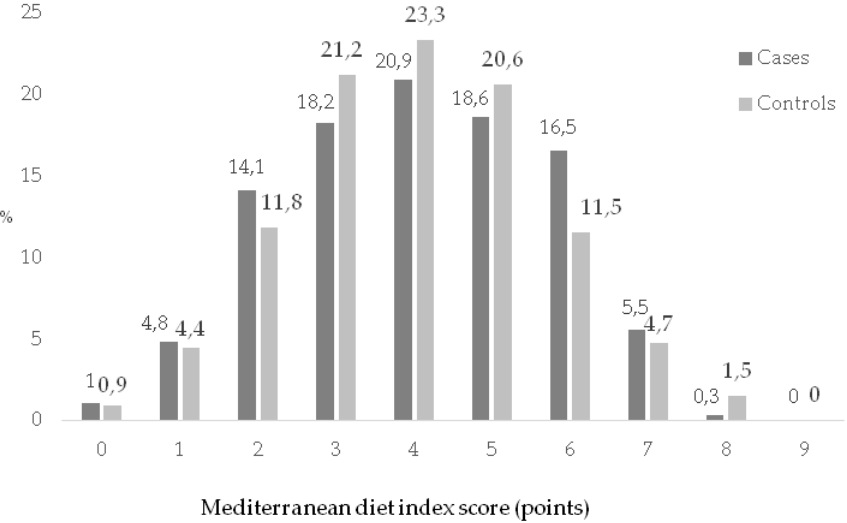
Table 1. Description of cases with gestational diabetes mellitus and the controls without gestational diabetes mellitus. Figure 2. Distribution of adherence to Mediterranean diet in the study population. Table 2. Consumption of the components of the Mediterranean diet in the cases with gestational diabetes mellitus and the controls without gestational diabetes mellitus.